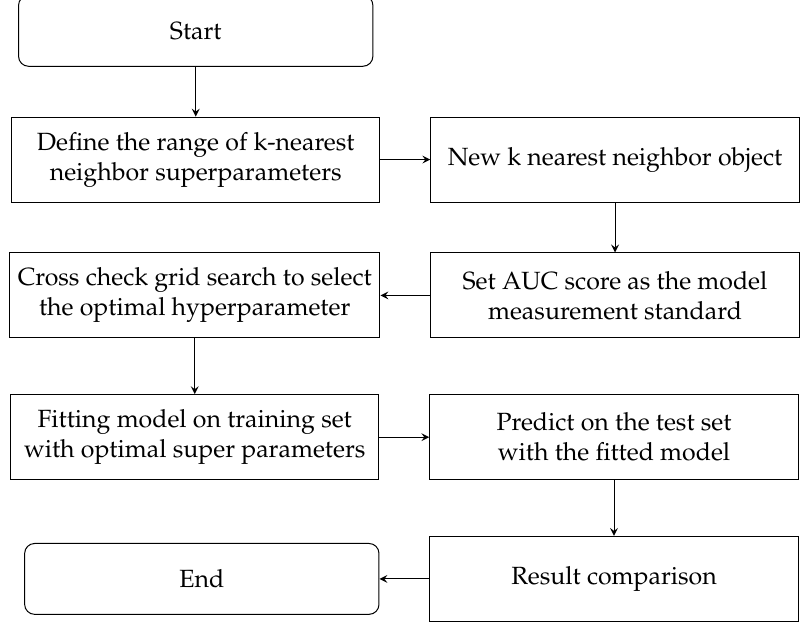
Figure 3. Prediction flow chart based on K-nearest neighbor